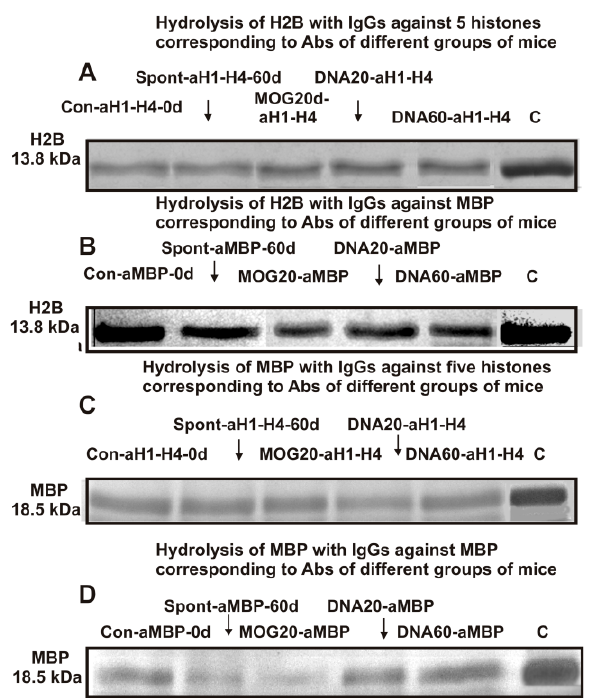
Figure 1. SDS-PAGE analysis of H2B (13.8 kDa) hydrolysis by IgGs against the five histones ( A ) and Abs against MBP ( B ) as well as splitting myelin basic protein (18.5 kDa) by antibodies against the five histones ( C ) and IgG-abzymes against MBP ( D ). Lanes C correspond to the histones ( A , B ) and MBP ( C , D ) incubated without IgG-abzymes. MBP and a mixture of five histones with and without IgGs (0.03 mg/mL) were incubated for 14 h. The full gel pictures are given in Supplementary Data (addition to Figure 1).